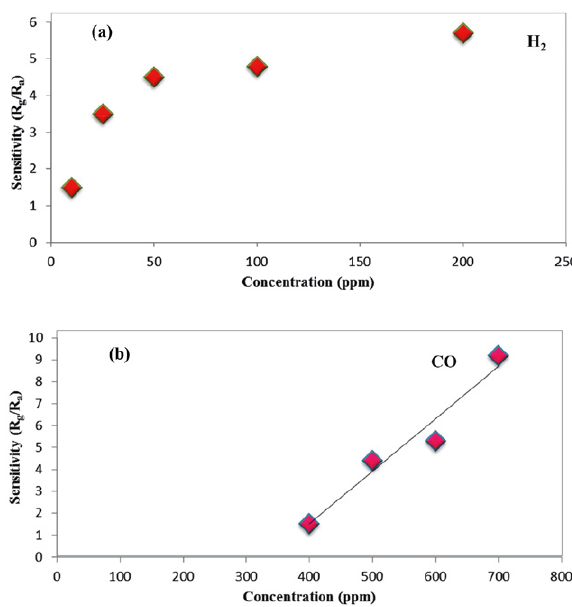
Figure 11 : Responses of the calcinated CuO nanofibers sensor to different concentrations of (a) H 2 and (b) CO at 175 °C.